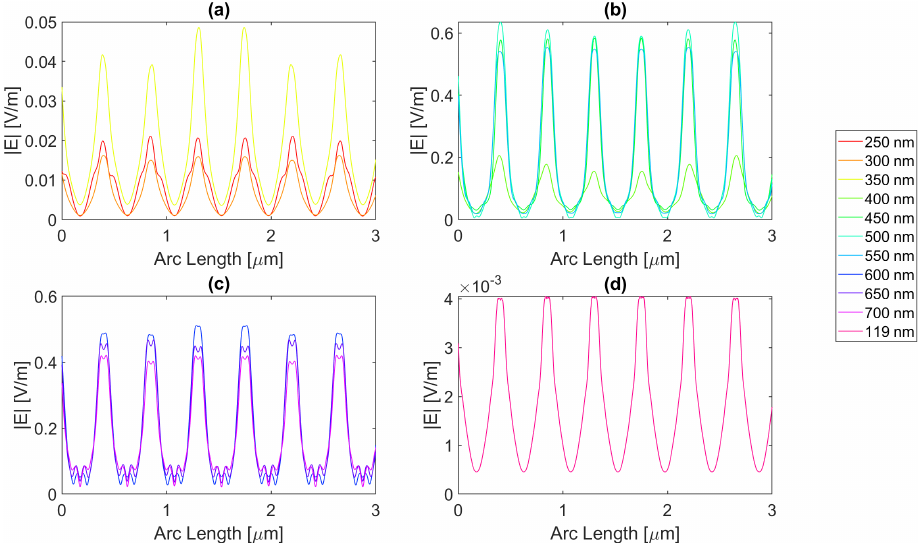
Figure 25. Electric field for the aluminium triangular nanostructure with a 200 nm base—Probe